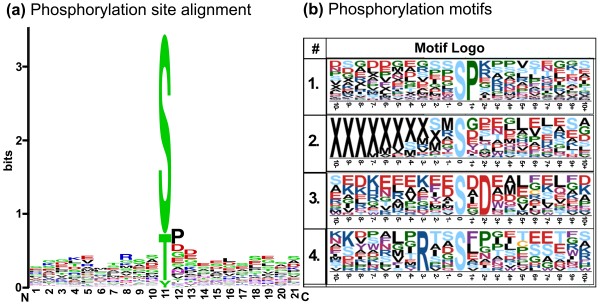
Sequence alignment of phosphorylation sites and extraction of significantly enriched phosphorylation motifs. (a) Amino acid sequence around the phosphorylated amino acid based on alignment of all phosphorylation sites from the identified DTBs phosphopeptide dataset using Weblogo. (b) Motif-X-extracted motifs from entire phosphopeptide dataset. JGI Populus trichocarpa v1.1 protein database was used as the background database to normalize the score against a random distribution of amino acids. Note that only those phosphorylated amino acids that were confidently identified as the exact site of phosphorylation were used for the analysis (see "Materials and Methods" for detailed description). Motif 1, Pro-directed kinase motif (n = 40); Motif 2, Unknown phosphorylation motifs (n = 20); Motif 3, CKII motif (n = 17); Motif 4, 14-3-3 binding motif (n = 13).